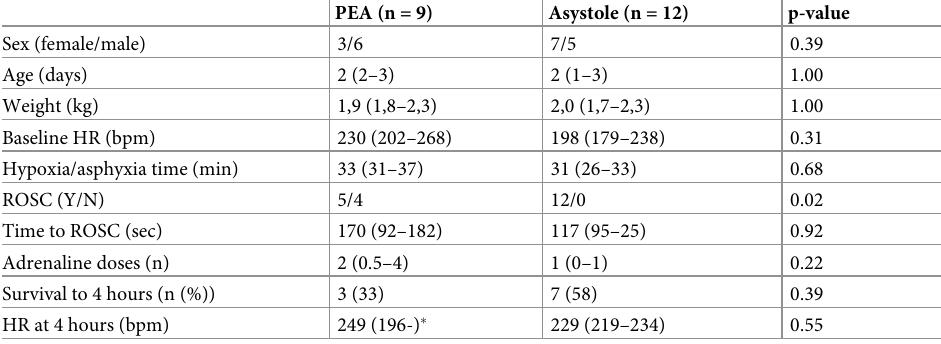
Table 1. Characteristics of piglets with pulseless electrical activity (PEA) versus asystole on electrocardiogram at cardiac arrest.